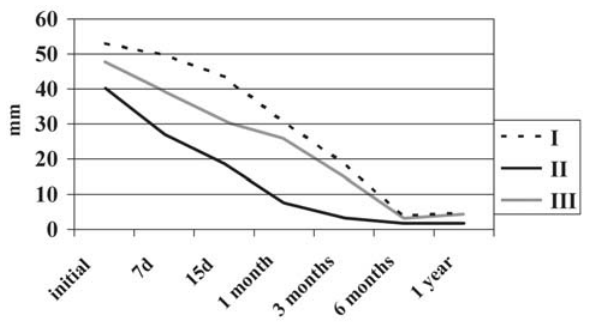
FIGURE 1- Pain report evaluation for different